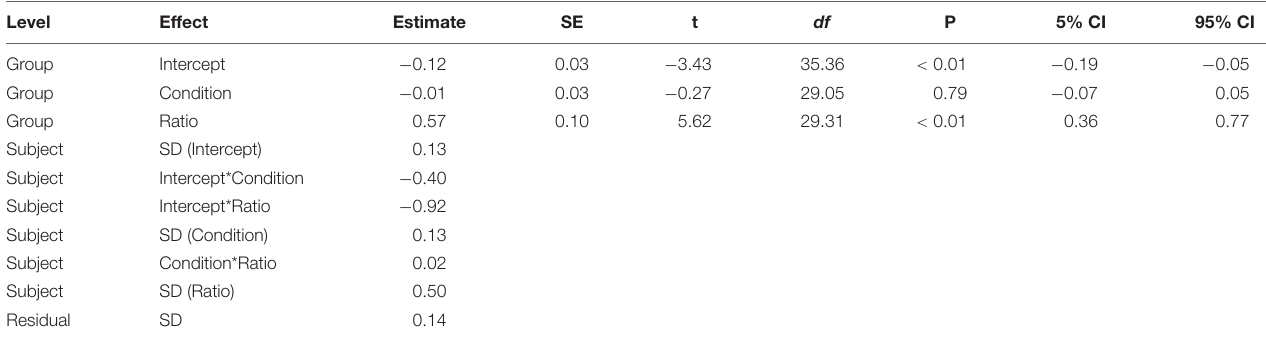
TABLE 2 | Linear Mixed Model for the effect of condition (Loss = 0, Reward = 1) and ratio between immediate and delayed options (0.2, 0.4, 0.6, 0.8) on relative frequency of discounted choices during the decision phase ( N =